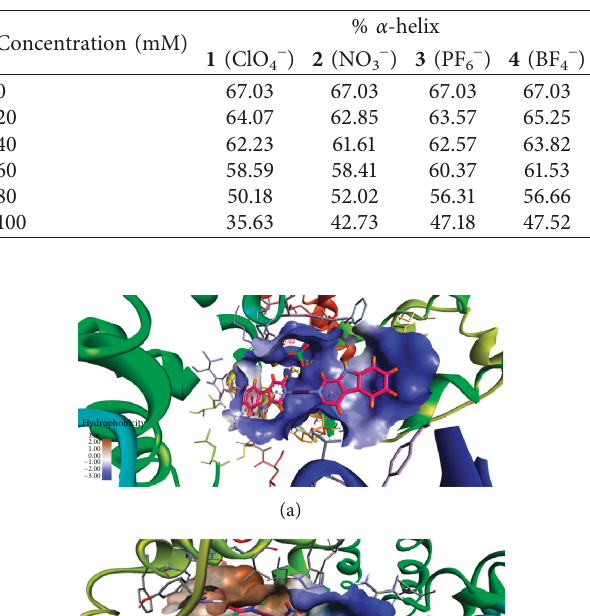
Table 3: Effect of the Ag(I) compounds on the α -helical structure of HSA (model protein) expressed as percentage α -helix character.